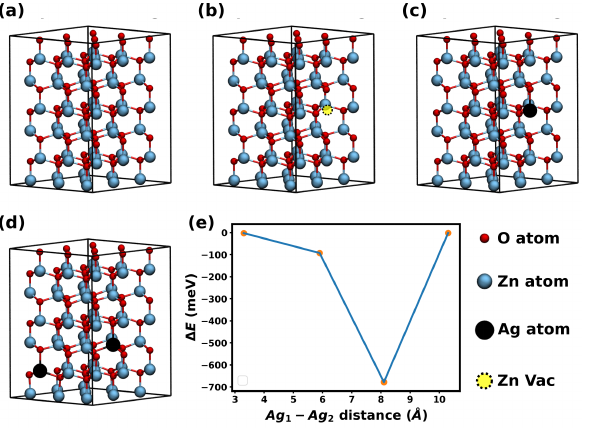
Figure 4. ZnO structures investigated here. Specifically, the sketches show the supercell used in the simulation for the ( a ) pure; ( b ) one Zn vacancy; ( c ) one Ag dopant; ( d ) two Ag dopants systems. We studied four structures with two Ag dopants, and the other three are omitted. The distance between Ag atoms differs in these structures. ( e ) The energy difference between ferromagnetic and antiferromagnetic configurations for the four ZnO structures containing two Ag